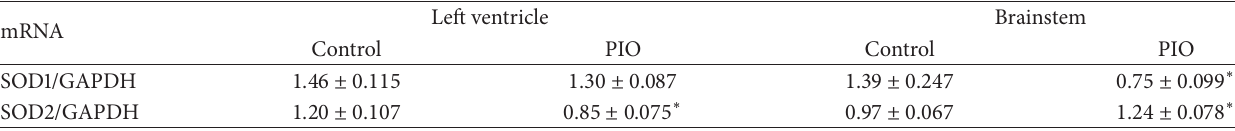
Data represent mean ± SEM, ∗ 𝑃 < 0.05 , PIO versus